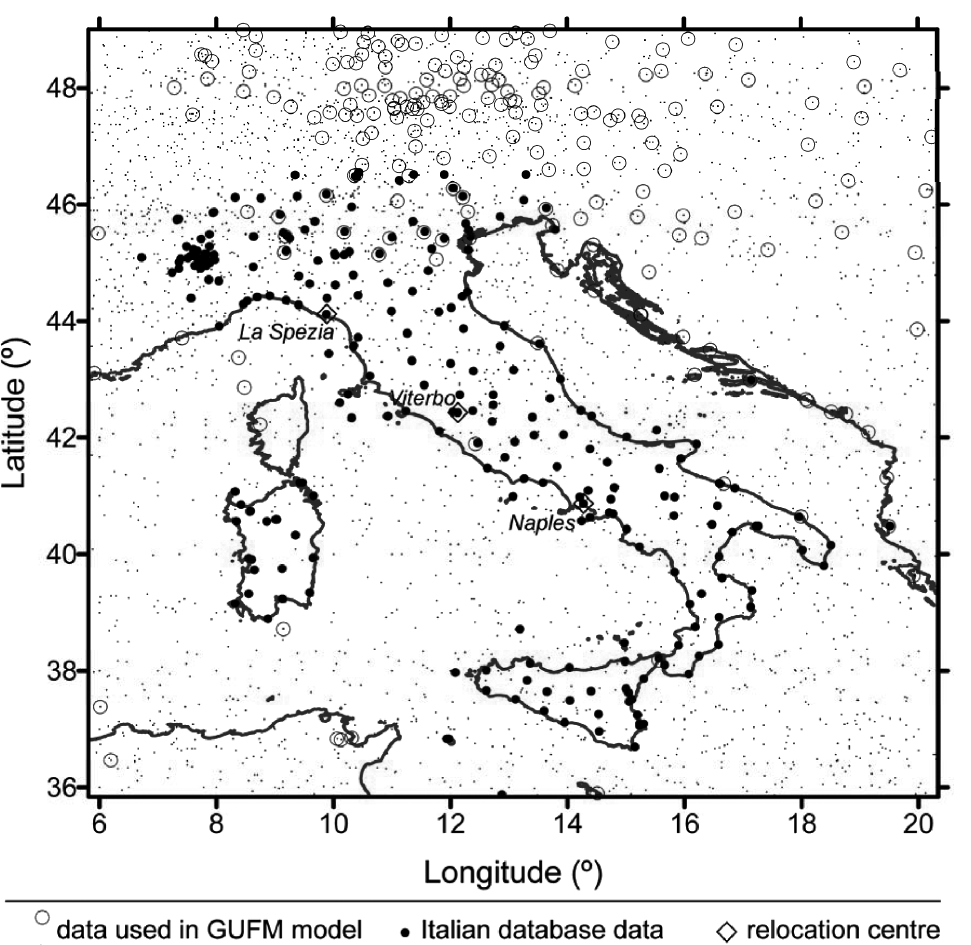
Fig. 1 . Map of Italy and neighbouring areas with indication of several data locations: solid dots (•) indicate dec- lination and inclination data at a given time from the Historical Italian Geomagnetic Data Catalogue (Cafarella et al. , 1992a); open dots ( (cid:1) ) indicate declination and inclination data at a given time from the database used to compute GUFM1 model; small dots (·) indicate single data values (declination or inclination) from the database used to compute GUFM1 model and finally open diamonds ( (cid:2) ) indicate the three locations selected as reloca- tion